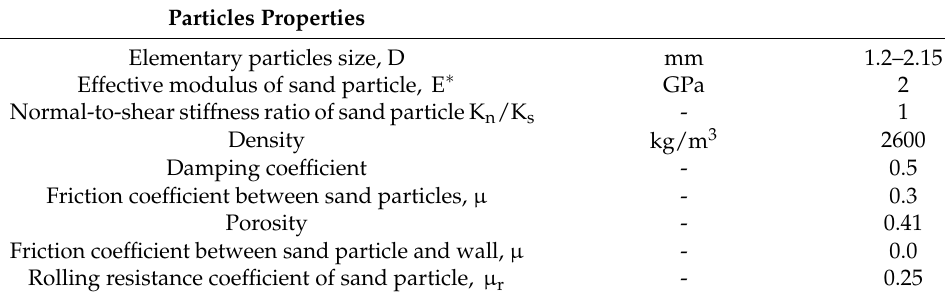
Table 2. Microscopic parameters for DEM simulation.